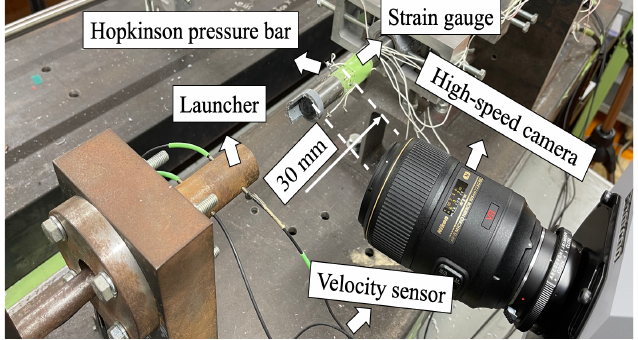
Fig. 1. A photo of the apparatus based on an instrumented Taylor impact